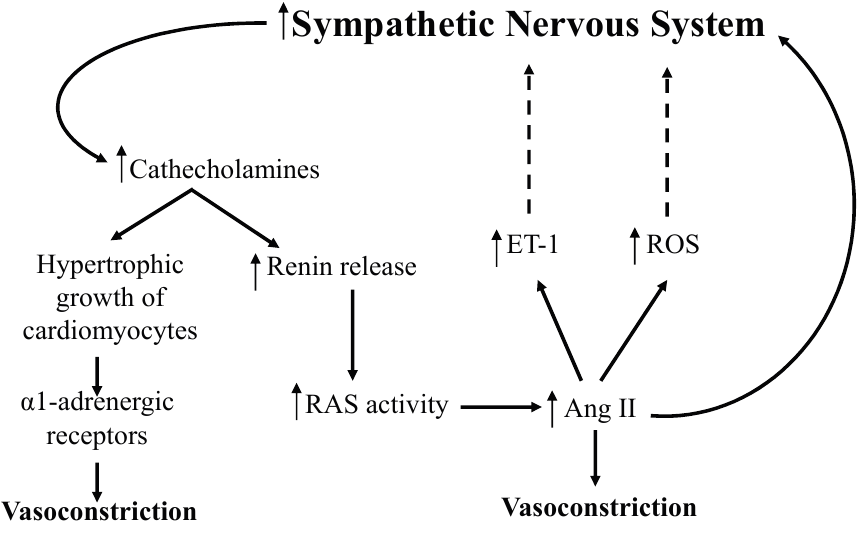
Figure 3. Regulation of blood pressure through autonomic nervous system. Increased sympathetic nervous system stimulates the release of cathecholamines from post ganglionic neurons. Cathecholamines increases the hypertrophic growth of cardiomyocytes and release more renin in adrenal cortex. Increase production renin over activates renin angiotensin system (RAS) and produces more Angiotensin-II (Ang II). Hypertrophic growth of cardiomyocytes and increase production of Ang II results in vasoconstriction. In addition, Ang II production increases ET-1 (Endothelin-1) and ROS (reactive oxygen species) production and directly affect the over activity of sympathetic nervous